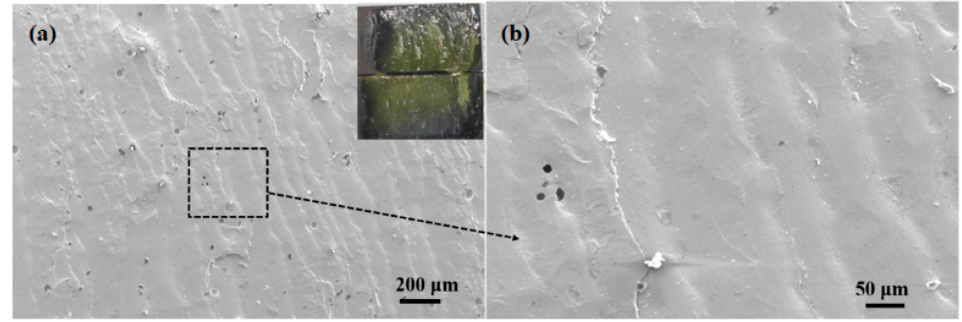
Figure 15. Fracture morphology of the joint made at brazing temperature of 495 °C for 30 min: ( a ) macro and low magnification morphology; ( b ) magnification morphology 3.5. Air Tightness Test of Brazing Joints.